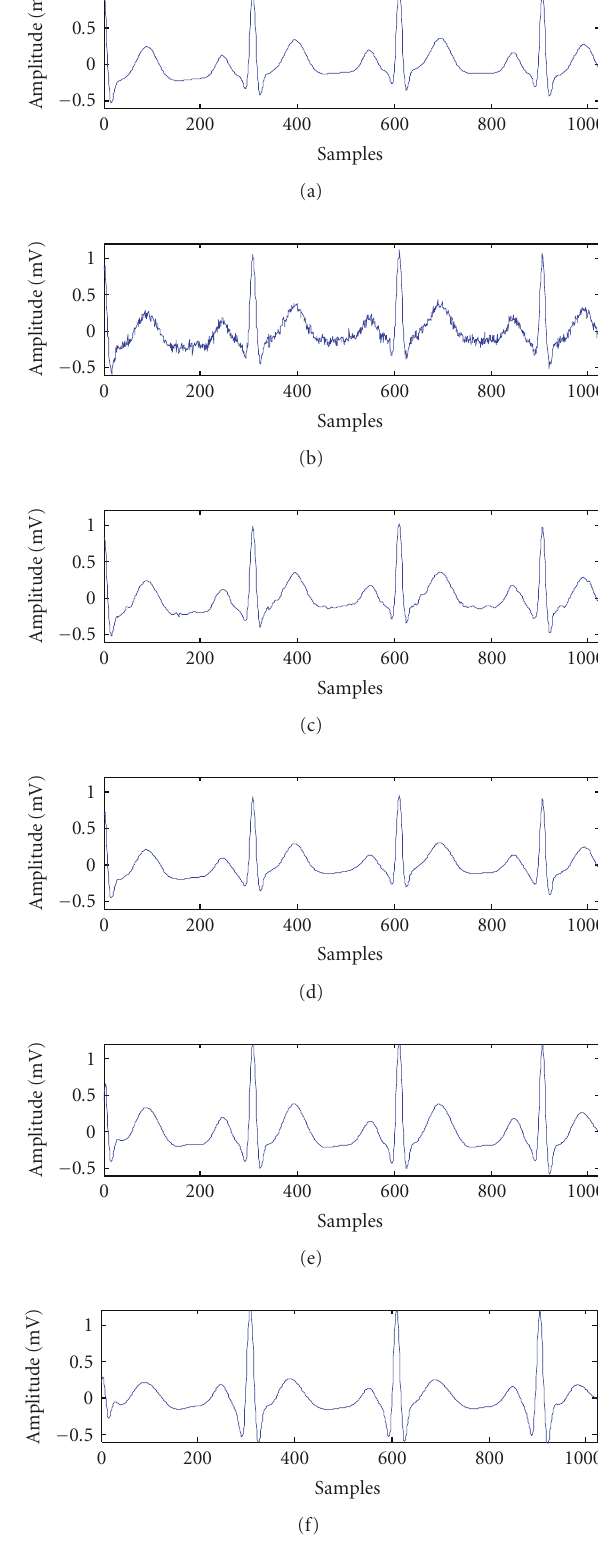
Figure 5: Typical results of di ff erent methods for an input simu- lated signal of 6 dB. (a) Clean ECG, (b) noisy input signal, (c) WT (hard), (d) WT (soft), (e) MABWT (hard), and (f) MABWT